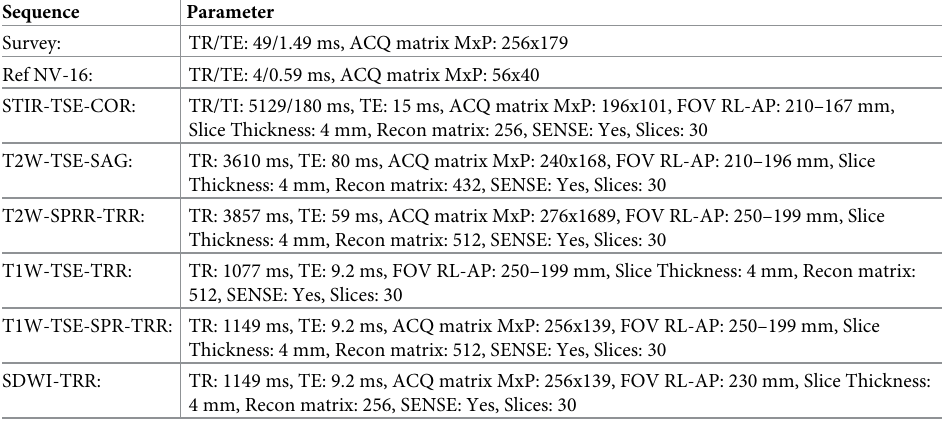
Table 2. Sequences and scan parameters employed in MRI